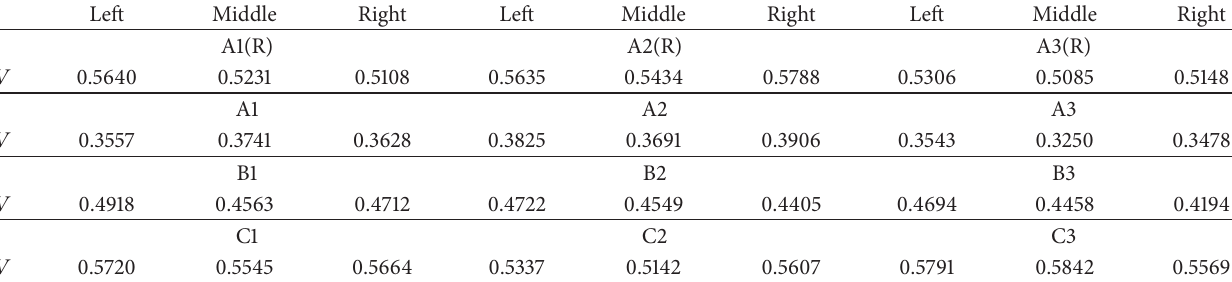
Table 2: The variation mean of every specimen’s three lines and three